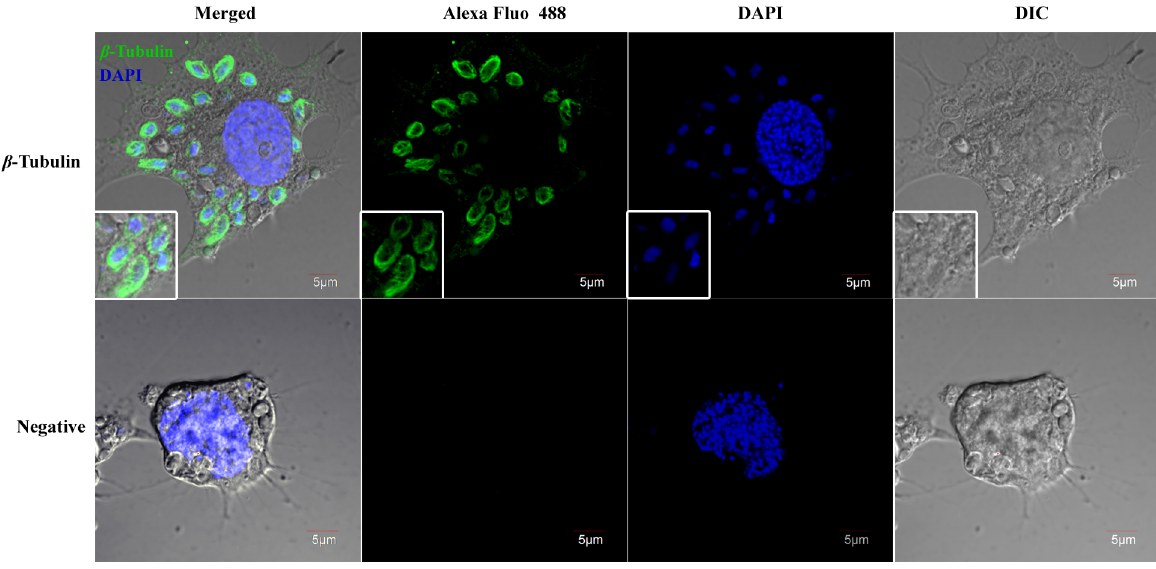
Fig 2. Location of β -Tubulin in intracellular microsporidian N . bombycis . Images were taken by laser scanningconfocal microscopyusing filter sets for Alexa fluo 488 labeling β - Tubulinproteinsand DAPI stainingnucleus.Immunofluorescence assay with β - Tubulin antiserum demonstrated that the membraneand cell plasma locationcontainedin N . bombycis cells in the proliferative phase. (Bars = 5 μ m)